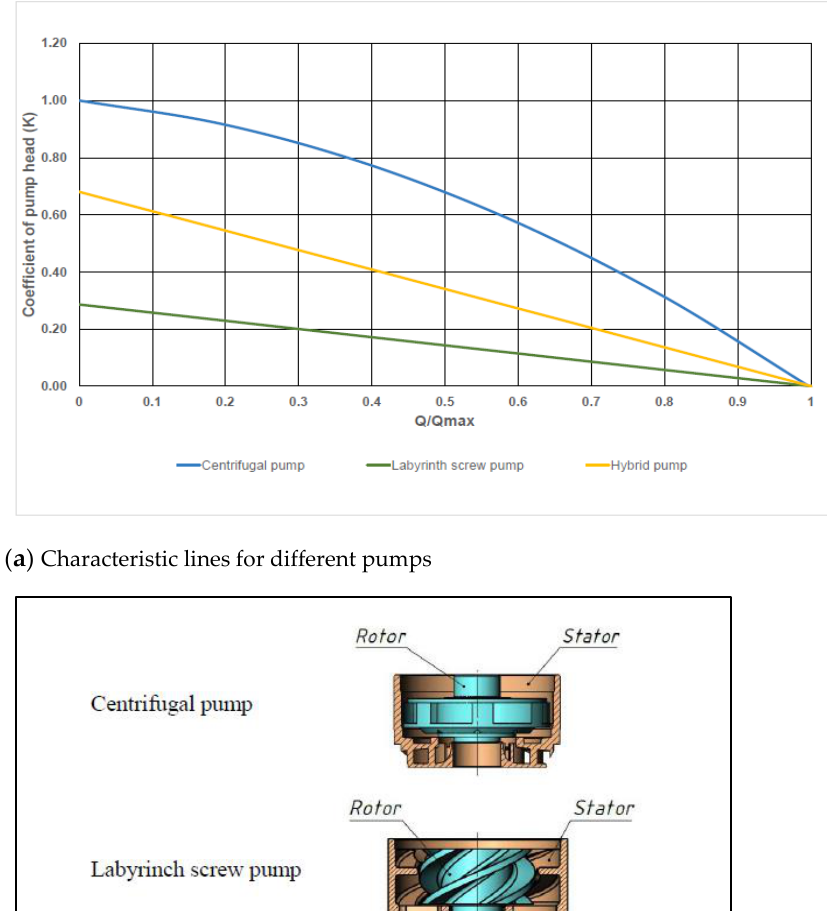
16 of 26 Figure 16. Impeller prototype of the new hybrid labyrinth pump. Source: authors’ development. 3.5. Results of Laboratory Tests of Hybrid Pump Prototype The results of laboratory tests revealed that the new hybrid pumps have a higher head and retain the positive qualities of the classical labyrinth screw pumps (Figure 17). Figure 17a shows a comparison of the head factors ( K ) for the labyrinth pump, cen- trifugal pump, and hybrid pump. A dimensionless parameter (Q/Q max ) equal to the pump supply ratio (Q) to the maximum pump supply (Q max ) is used to estimate the pump oper- ating mode. Coefficient of pump head: 𝐾 = (𝐻/𝐿)/(𝐻1/𝐿1) , where H is the pump head, L is the